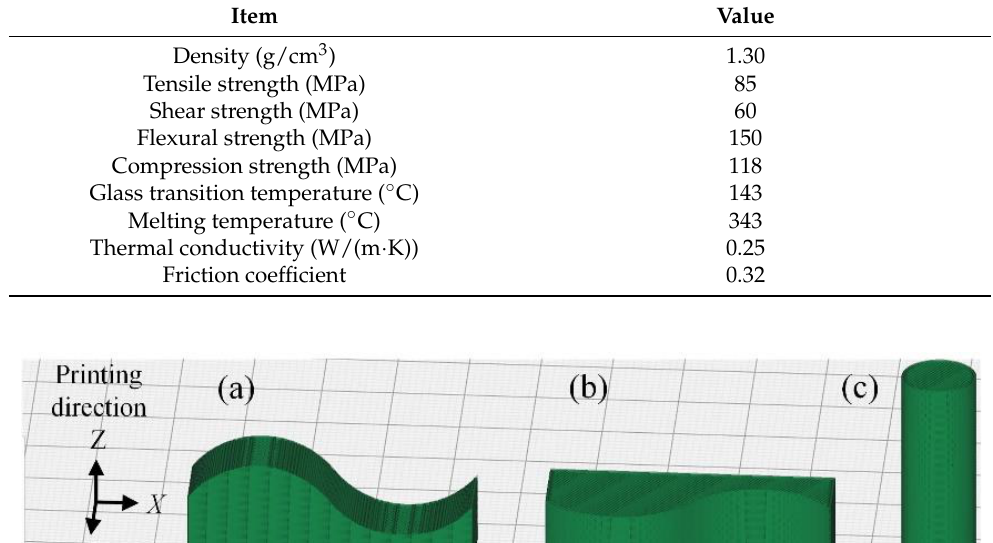
Table 1. Material properties of the tested PEEK.